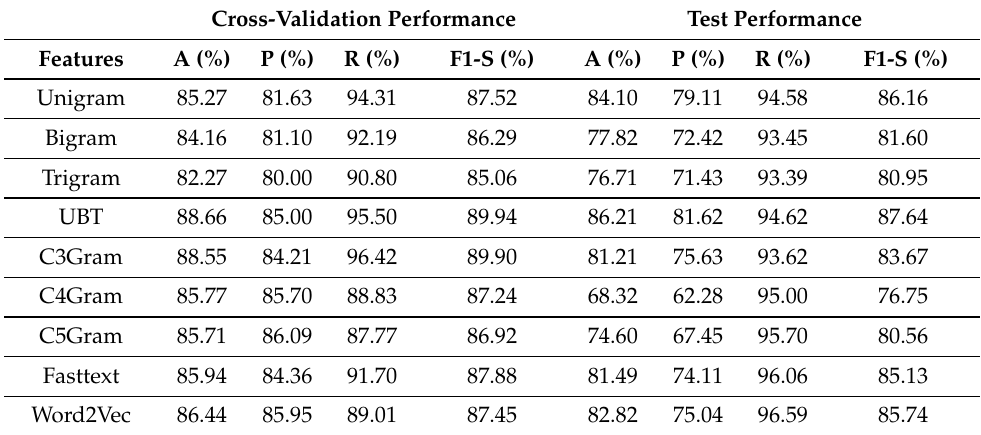
Table 4. Performance of logistic regression (LR) machine learning classifier.